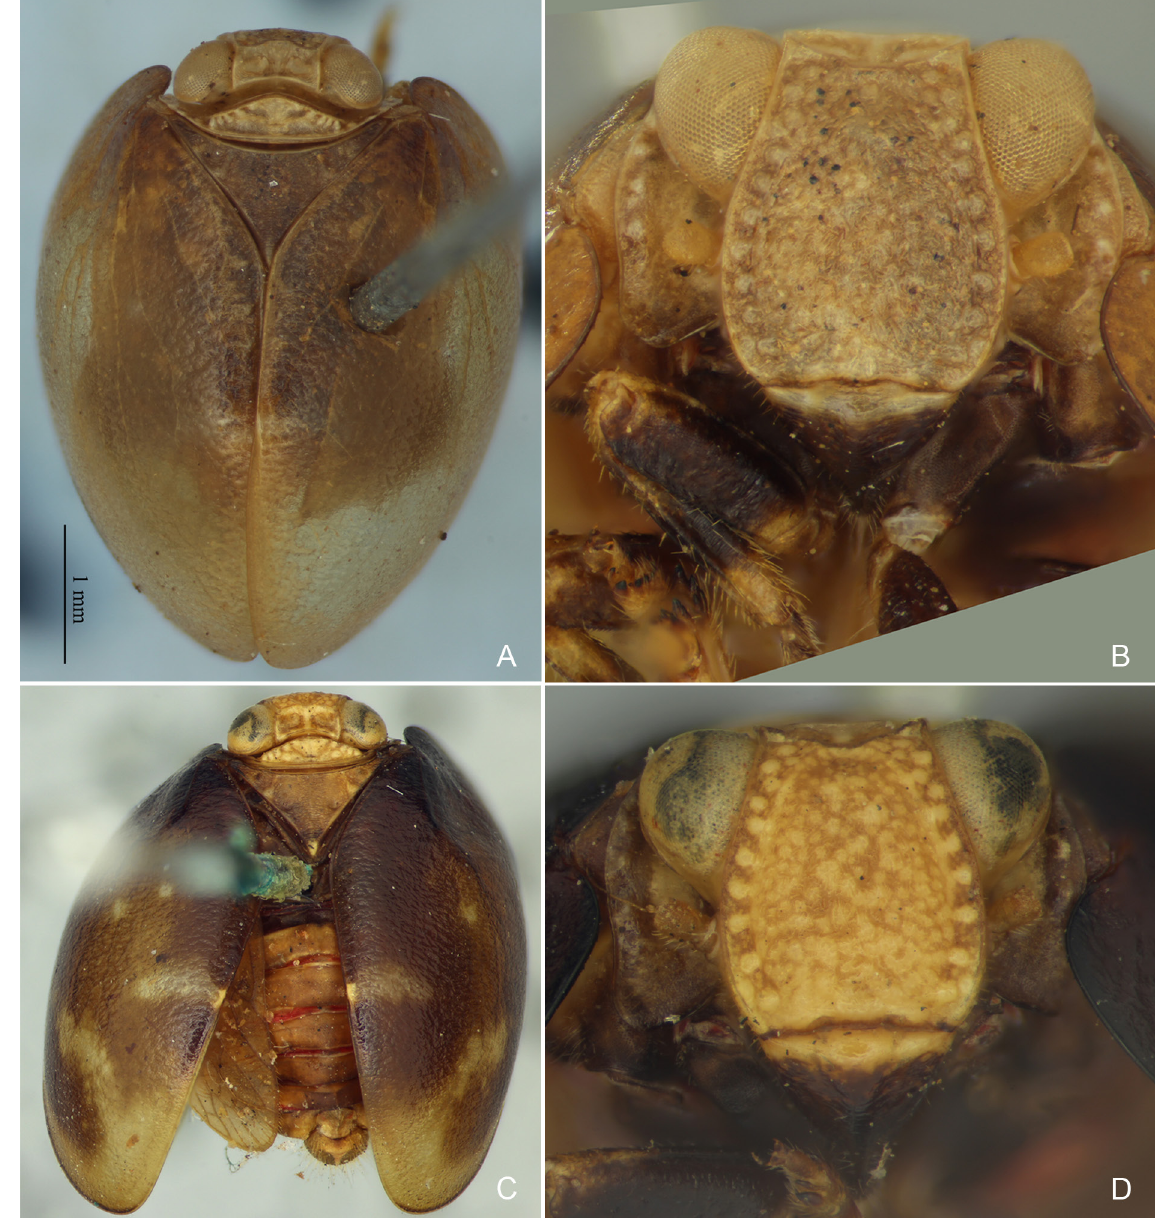
Fig. 8. Mongoliana spp. A–B . Mongoliana chilocorides (Walker, 1851), holotype. A . Habitus, dorsal view. B . Frons and clypeus, facial view. — C–D . Mongoliana recurrens (Butler, 1875), holotype. C . Habitus, dorsal view. D . Frons and clypeus, facial